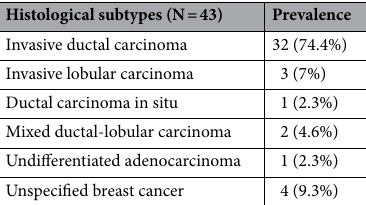
Histological subtypes (N =